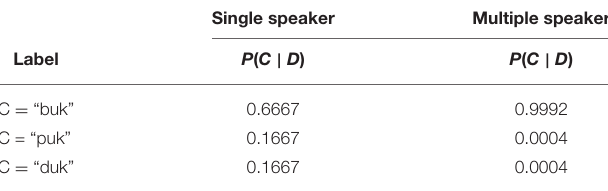
TABLE 3 | Posterior probability of the label after seven observations of